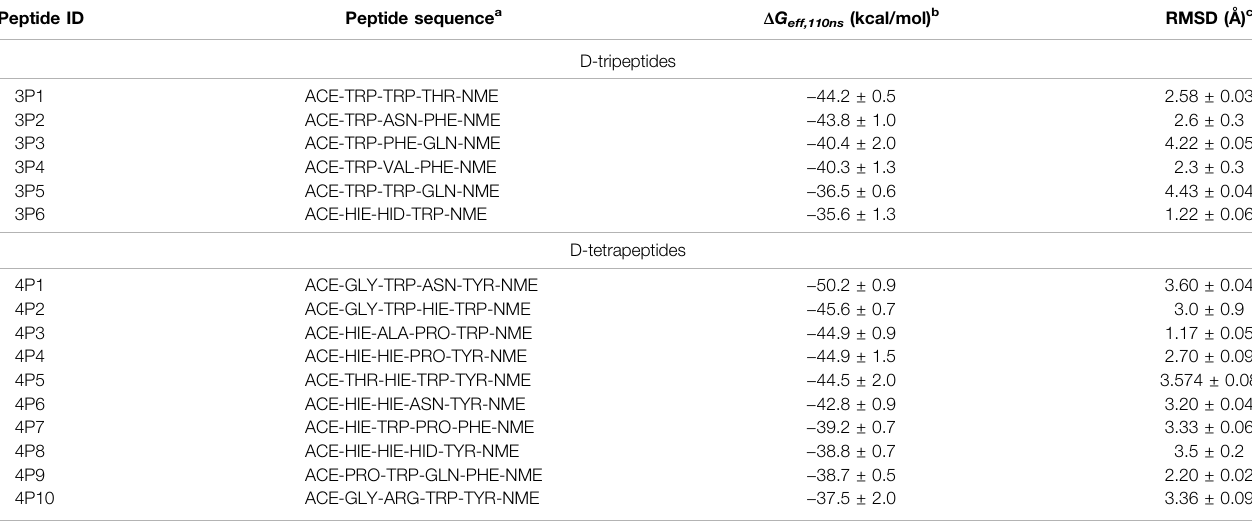
a Residues are shown in three-letter code and separated by hyphens. ACE and NME are the N- and C-terminal caps added to the D-peptides. HIE and HID are HIS tautomers. b MM-GBSAaverageeffectivefreeenergiescalculatedoverthelast70nsofeach110nsMDtrajectory ± SEMsestimatedthroughblockaveraging.Seeinstantaneous Δ G eff valuesvstime plots for every system along their respective 110 ns MD simulations in Supplementary Figure S2 . c Mean RMSD values for the peptide heavy atoms with respect to the starting structure ( t (cid:1) 0) calculated over the last 20 ns of each 110 ns MD trajectory ± standard errors of the mean estimated through block averaging. See RMSD values vs time plots for all systems along their respective 110 ns MD simulation in Supplementary Figure S3